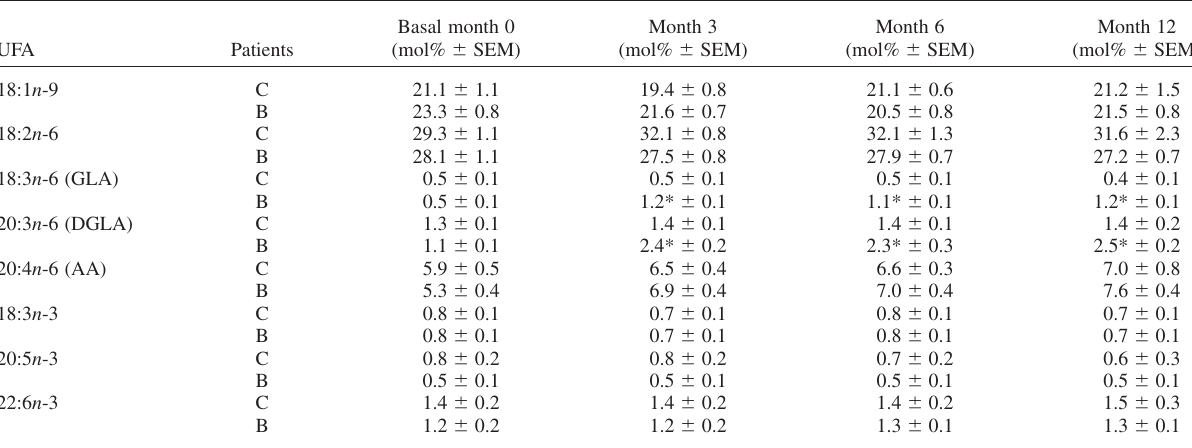
RESULTS Fatty Acid Profile in the Dietary Borage Oil and Corn Oil Aliquots of 10 m l from each of the capsules containing either borage oil or corn oil was extracted first with CHCl :CH OH (2:1, v/v) and taken to dryness under 3 3 nitrogen gas. The transmethylation and preparation of fatty acid methyl esters are as described in the “Method” section. Table I illustrates the fatty acid profiles in the dietary capsules. The major polyunsaturated fatty acid (PUFA) in the borage capsule was GLA (18:3 n -6) whereas the major PUFA in the placebo (corn oil) was linoleic acid (LA, 18:2 n -6). Arachidonic acid was negligible in both dietary oils. Fatty Acid Profile in the Sera of Patients The fatty acid profile of both the placebo (corn oil) and the experimental (borage oil) groups are shown in Table II. TABLE II Time-dependent influence of dietary supplimentation with corn oil and borage oil on patients’ serum unsaturated fatty acids level UFA